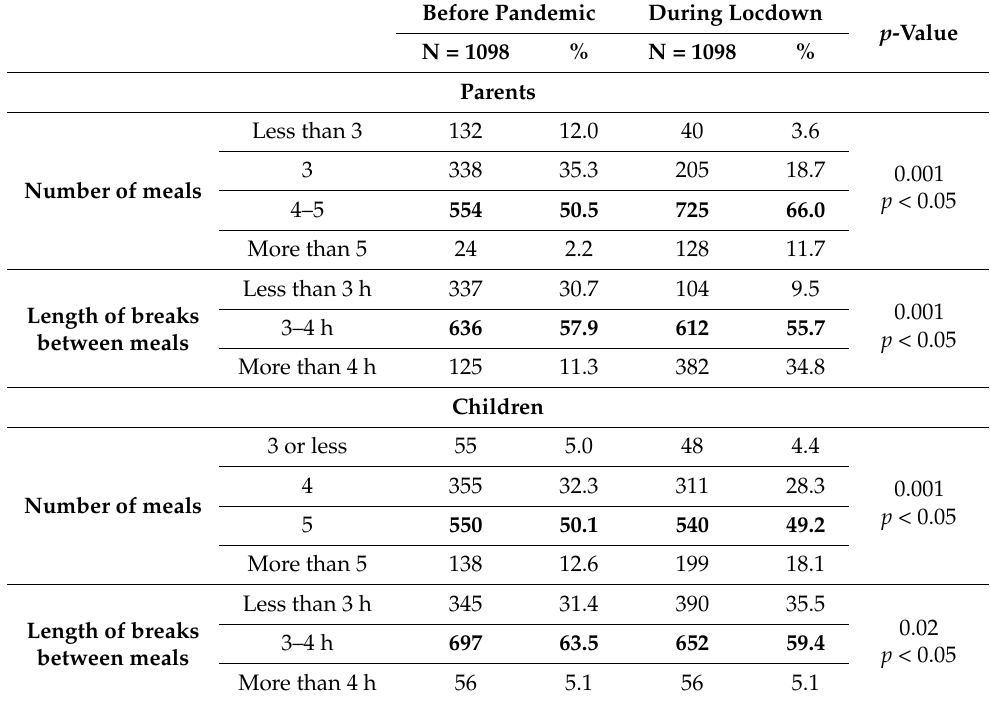
Table 1. Selected meal-related